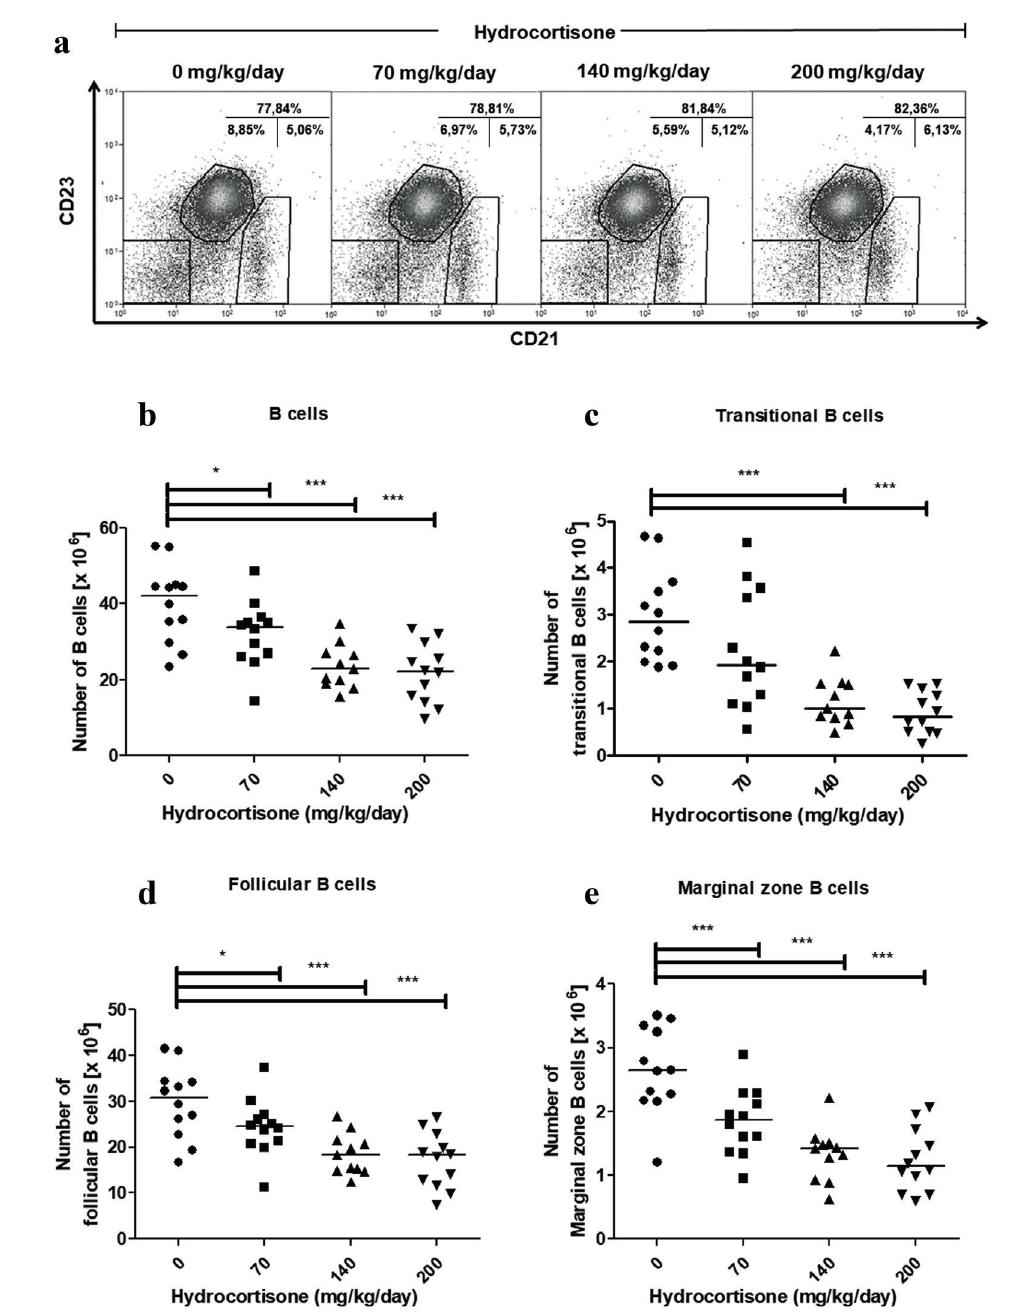
Figure 4 - Effect of in vivo treatment with hydrocortisone on subsets of spleen B cells. Mice were injected with diluent or hydrocortisone (70, 140 or 200 mg/kg/day) for 3 consecutive days. In the next day, spleen cells were counted and stained with monoclonal antibodies for CD19, CD21 and CD23 molecules for analysis by flow cytometry. ( a ) Percentage of spleen B cells subsets, ( b ) total number of B cells (CD19+), ( c ) transitional B (CD19+CD21-CD23-), ( d ) follicular B (CD19+CD21lowCD23+) and ( e ) marginal zone B cells (CD19+CD21highCD23-). Line represents the median, (*) represents values of p<0.05 and (***) p<0.001, according to the statistical test. Results are representative of 4 independent experiments with 3 mice/group